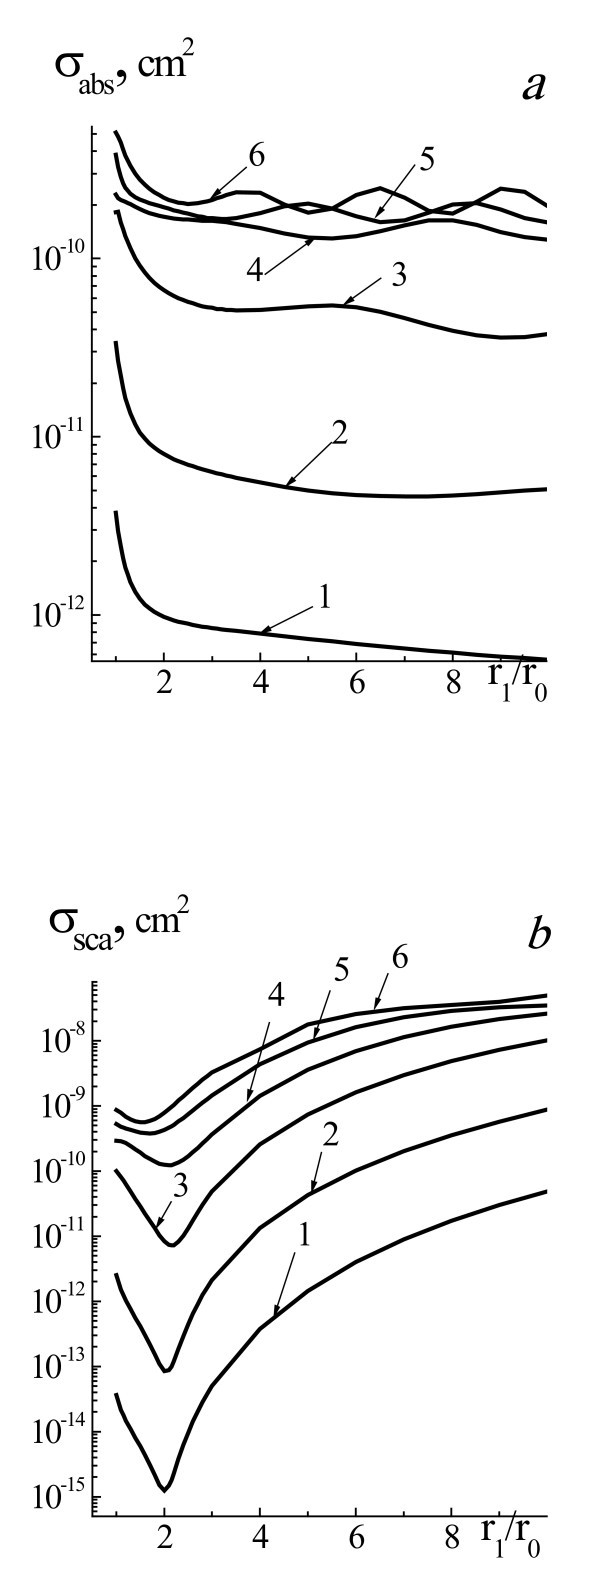
Efficiency cross sections σabs (a) and σsca (b) of laser radiation. With wavelength 532 nm by two-layered spherical system gold NP core and water vapor shell for the radii r0 = 10 nm (1), 20 nm (2), 40 nm (3), 60 nm (4), 80 nm (5), and 100 nm (6), and for the range of system radii r1 = (1 ÷ 10) r0.